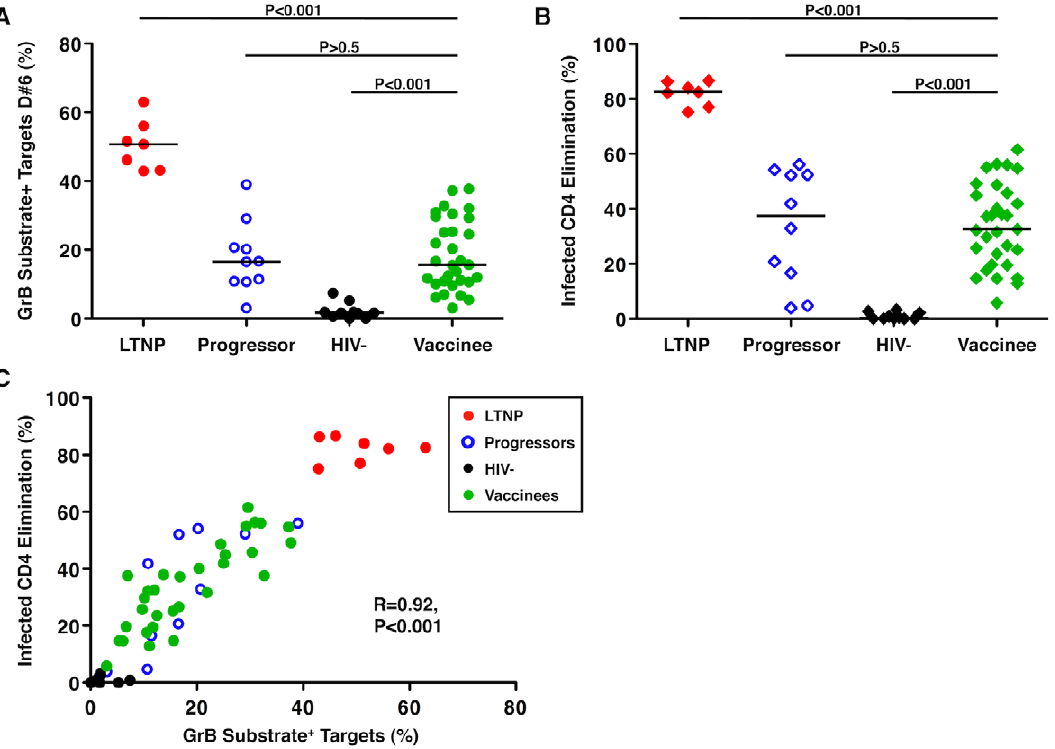
Figure 1. HIV-specific CD8 + T-cell cytotoxic responses induced by an Ad5/HIV vaccine were similar to those of progressors. (A, B) Summary data of the total cytotoxic response measured by GrB activity (circles, A) or infected CD4 + T-cell elimination (ICE) (diamonds, B) with day 6 (D # 6) CD8 + T-cells derived from LTNP (red symbols, n=7), progressors (blue symbols, n=10), HIV-negative individuals (black symbols, n=10) and Ad5/HIV vaccinees (green symbols, n=31). Data are representative of at least two experiments. Comparisons were made using the Wilcoxon two-sample test. Horizontal lines indicate median values. Only P values referring to comparisons between the responses of vaccinees and the other groups are shown. (C) Using D # 6 CD8 + T-cells, GrB target cell activity correlates directly with ICE (n=58). Correlation was determined by the Spearman rank method.